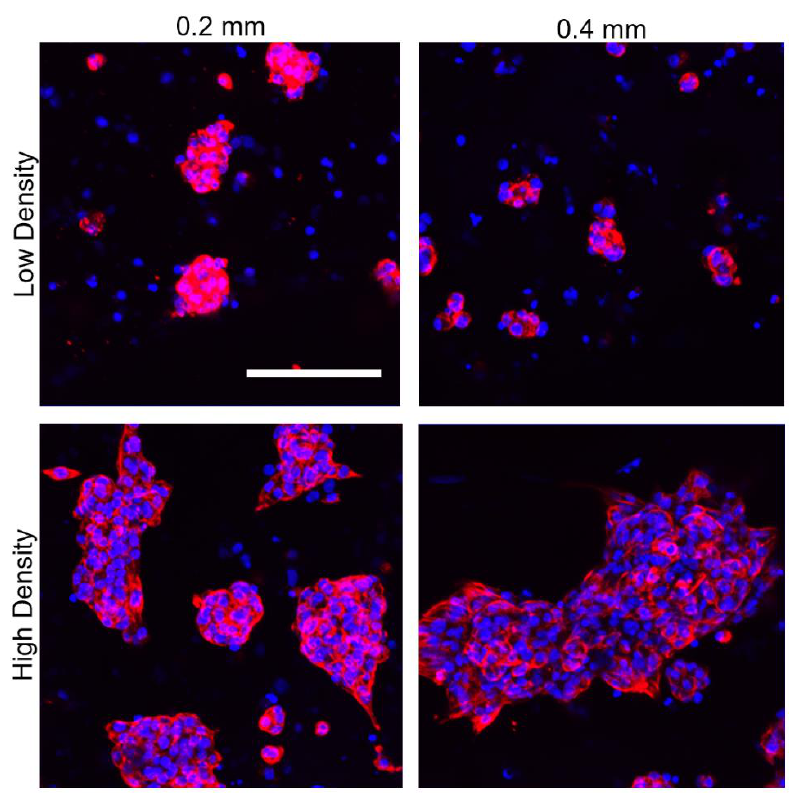
Figure 6. Maximum intensity projections from z-stacks of 0.2 and 0.4 mm high density and low density patches with iPSC-CMs stained against cardiac troponin T (red) and nucleus (blue) at day 14 of culture. Scale bar = 100 µm.